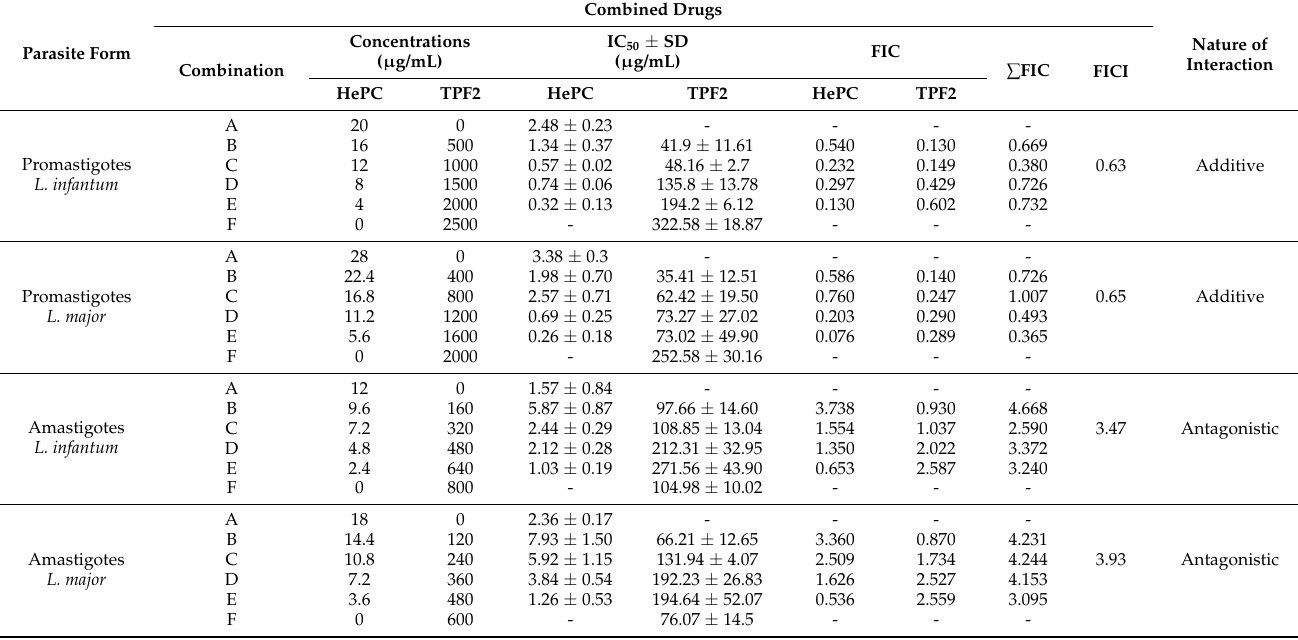
FIC, fractional inhibitory concentration at the indicated IC 50 . ∑ FIC, sum of the FICs. FICI, fractional inhibitory concentration index. In addition, the FICI values for the TPF1-HePC combination against intracellular L. infantum and L. major amastigotes were 2.22 and 2.48, respectively (Table 3), while TPF2-HePC combinations exhibited FICI values at 3.47 and 3.93, respectively. These FICI values indicated an antagonistic interaction between each TPF and HePC against intracellular amastigotes [31,32] (Tables 3 and 4). Lastly, the resulting effects of drug association were graphically evaluated by plotting the FIC values of the compounds in combination as isobolograms (Figures 8 and 9). The points corresponding to the FIC values were connected by tendency lines, while the dashed lines representing the additivity line range of confidence were constructed by the intersection of single medication IC 50